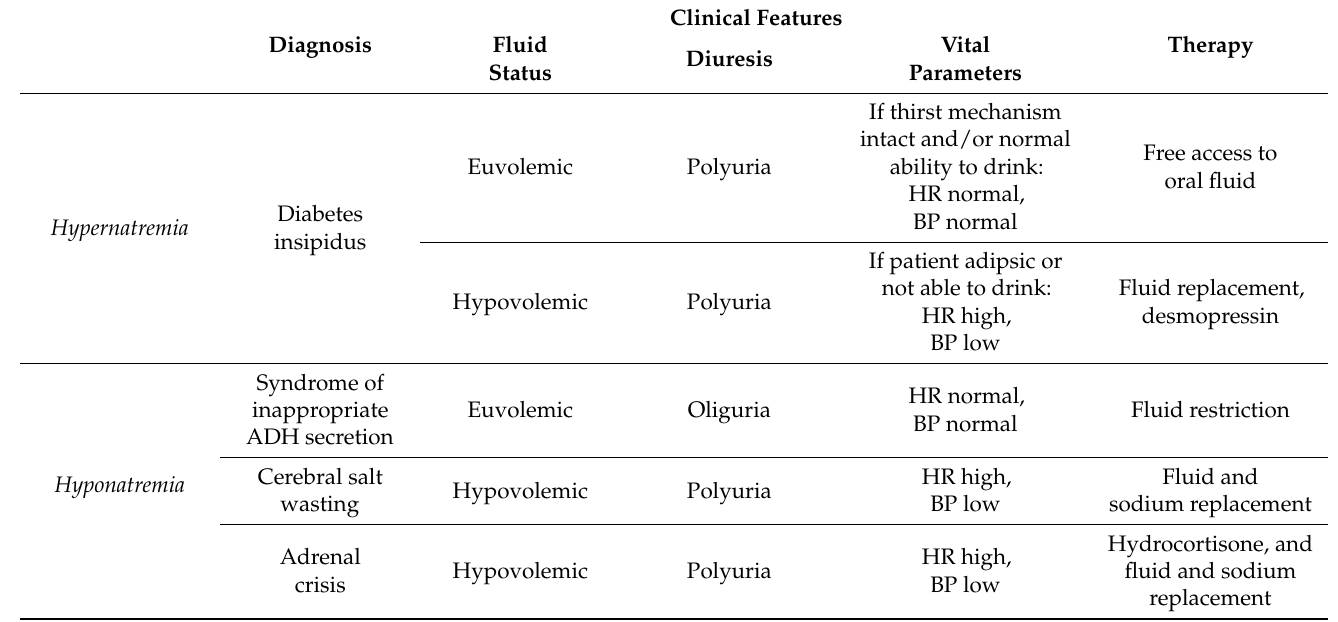
Table 2. Differential diagnosis of post-operative water homeostasis alterations